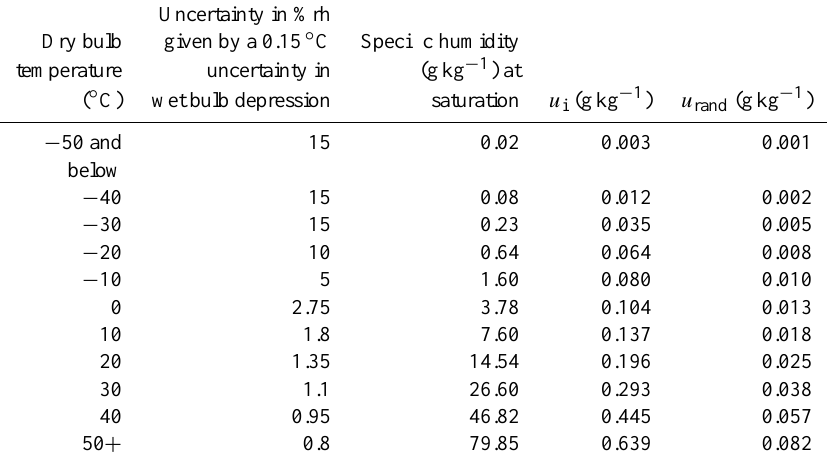
Table 2. Estimates of standard uncertainty in humidity measurements calculated in terms of equivalent psychrometer uncertainty to represent a “worst case scenario”. At lower temperatures the measurement uncertainty becomes large, but the low absolute specific humidity values make only a small contribution to global estimates of specific humidity. Calculations of specific humidity used Eqs. (1) to (5). Uncertainty in %rh Dry bulb given by a 0.15 ◦ C Specific humidity temperature uncertainty in (gkg − 1 ) at ( ◦ C) wet bulb depression saturation u i (gkg − 1 ) u rand (gkg − 1 ) − 50 and 15 below −